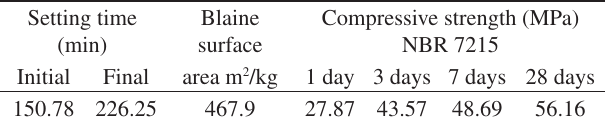
Table 2. Physical properties of